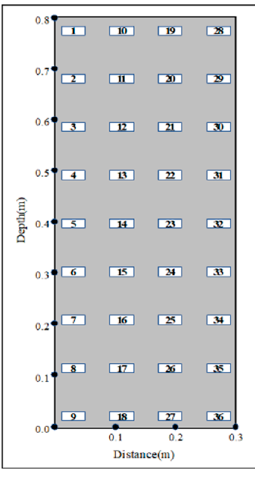
Figure 4. Location of temperature monitoring (side view).